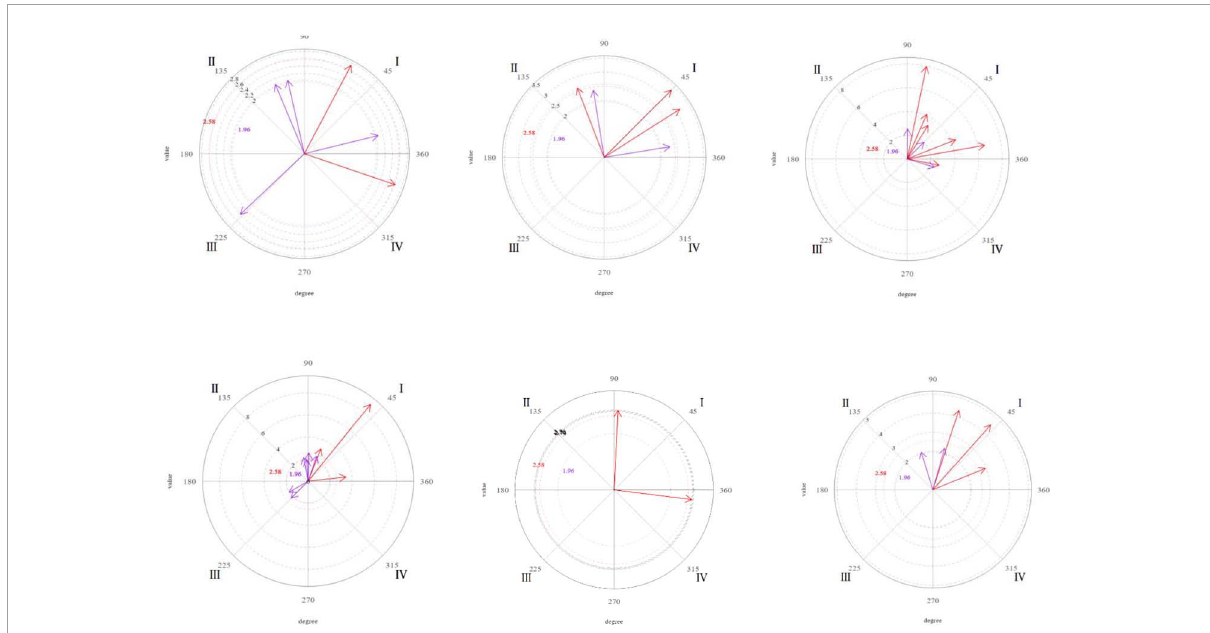
FIGURE2 Graphic representation of the significant (purple) and very significant (red) vectors obtained in the polar coordinate analysis. Focal behavior “Verbal imitation” as the center of the analysis and all the others as conditional of sessions 9, 16, and 20 (from left to right). Focal behavior “Non-verbal imitation” as the center of the analysis and all the others as conditional of sessions 9, 16, and 20 (from left to right).